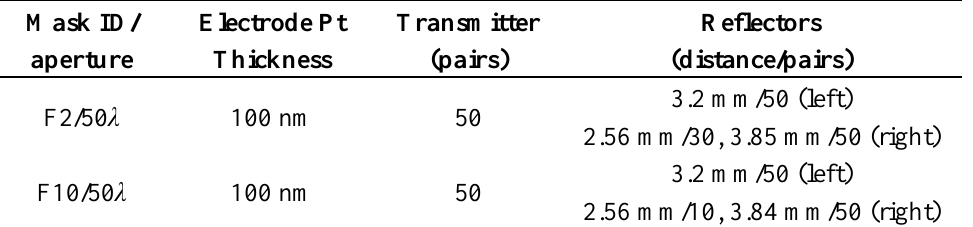
Table 2. Mask parameters for gas sensor